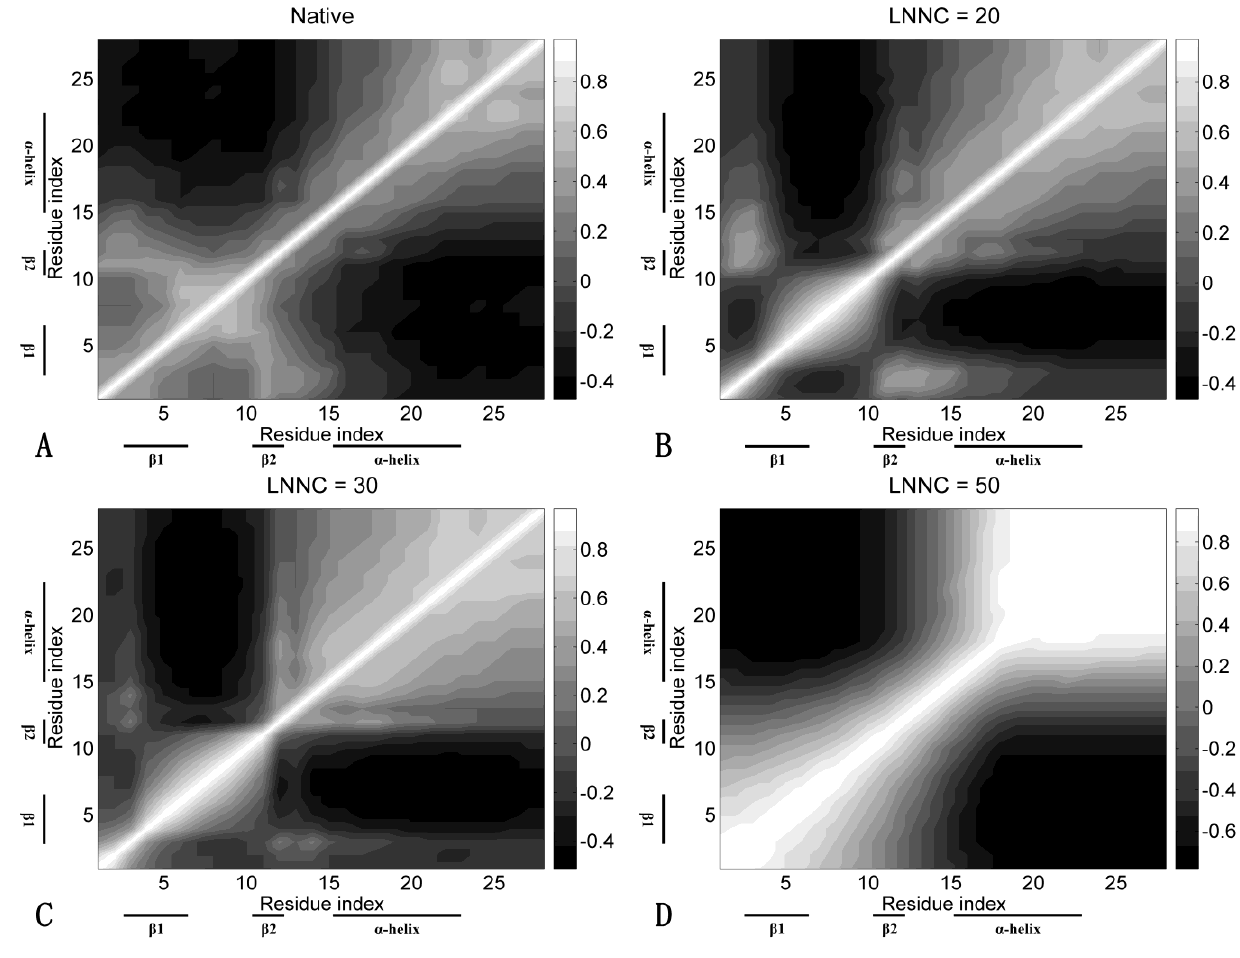
Figure 9. The cross-correlation maps for native conformation ( A ) and several conformations with LNNC to be 20 ( B ), 30 ( C ) and 50 ( D ) during the unfolding process of FSD-1. As shown in the bar on the right, the dark regions in the figure indicate negative correlation and the light regions present positive correlation. Both the x and y axes of the maps are residue